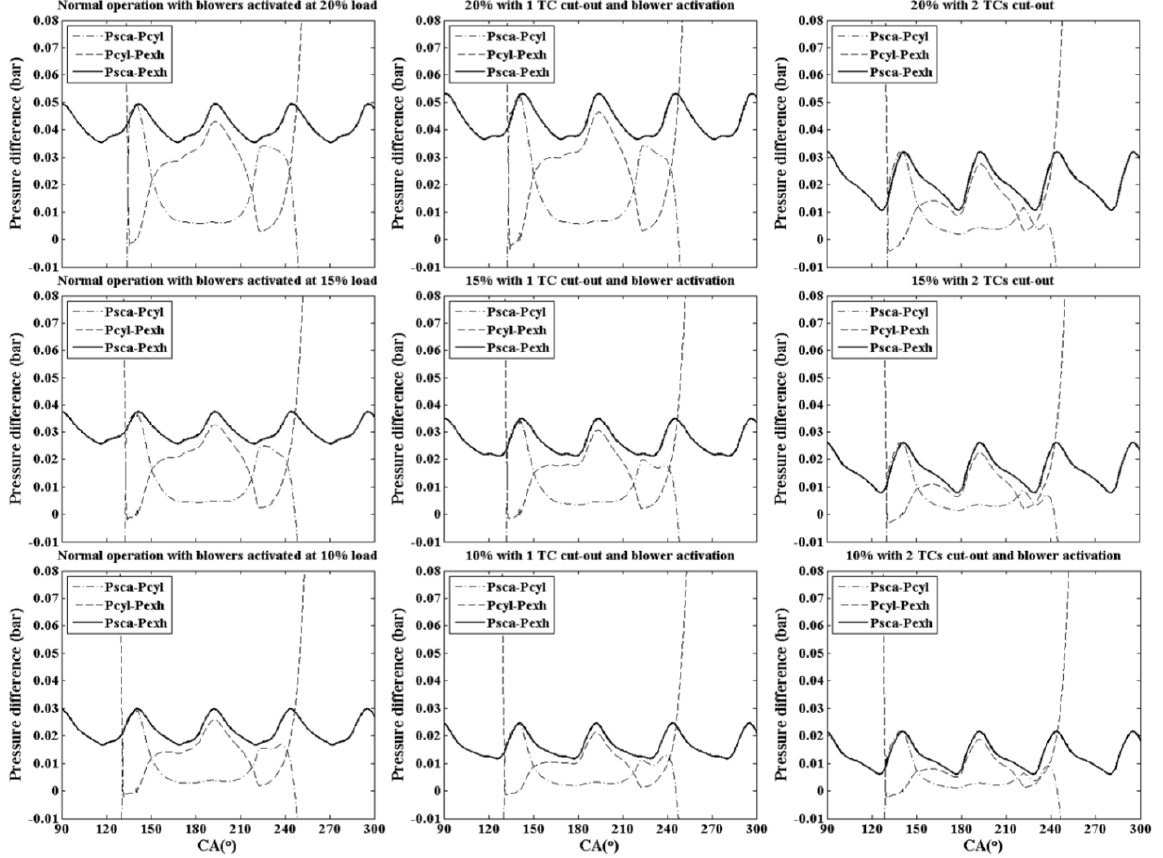
Figure 7. Cylinder pressure difference at different